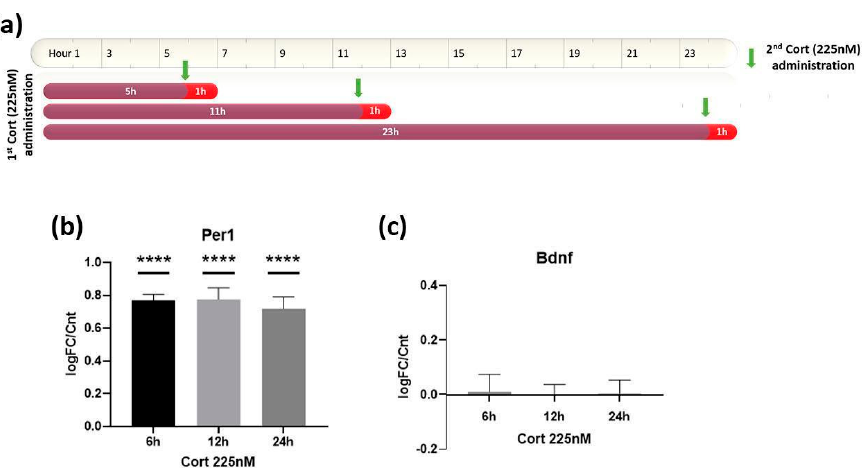
Figure 4. ( a ) Schematic illustration of the experimental design that was used to study the transcrip- tional effects of 2 Cort administrations on Bdnf in astrocytes. In all 3 treatments, the first dose of Cort is administered at the timepoint 0 h and then the second one exactly 1 h before the end of each treatment (5 h for the 6 h treatment, 11 h for the 12 h treatment and 23 h for the 24 h treatment). qRT- PCR was performed for RNA samples collected at the end of each timepoint. ( b ) Per1 mRNA ex- pression levels remained equally elevated at all 3 timepoints after the 2nd dose of Cort administra- tion (225 nM). ( c ) The second administration of Cort restored the Bdnf expression levels back to the untreated control ones independently of the time delay between the two pulses. n = 3 for each ex- periment. **** p < 0.0001; one-way ANOVA. Data are mean ± S.E.M.